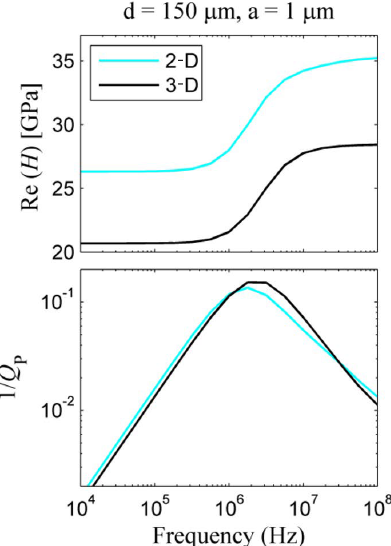
Figure 16. Real part of P wave modulus ( H ) and corresponding P wave attenuation (1 /Q P ), as functions of frequency, for the 2-D model shown in Fig. 7 and for its 3-D counterpart shown in Fig. 15. The grain diameter ( d ) and thickness ( a ) of the interfacial water film are indicated in the plot title. The fields shown in Figs. 10–12 correspond to this 2-D